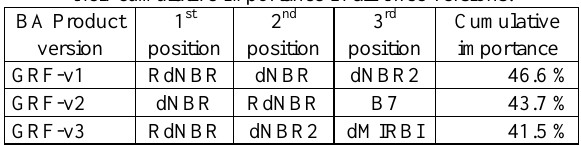
Table 1. The most important variables of the RF model and their cumulative importance in all three versions.